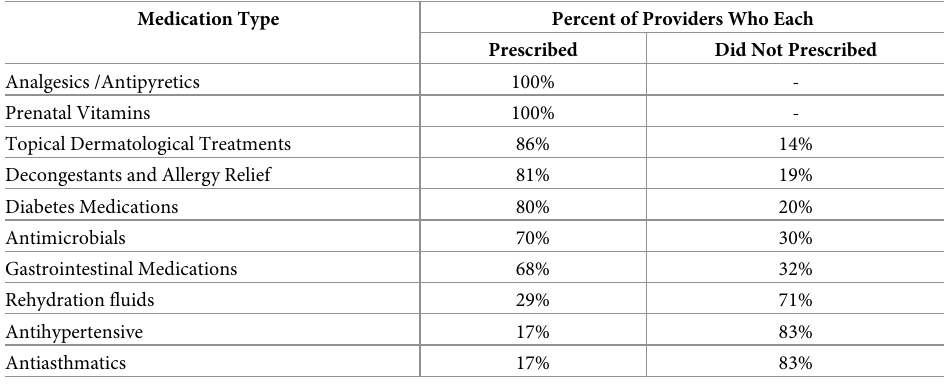
Table 3. Types of medication dispensed to asylum seekers by participating volunteer providers (n =